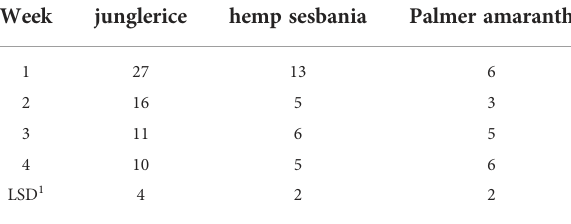
TABLE 3 Height reduction (%) of hemp sebania ( Sesbanea herbacea ), junglerice ( Echinochloa colona ), and Palmer amaranth (